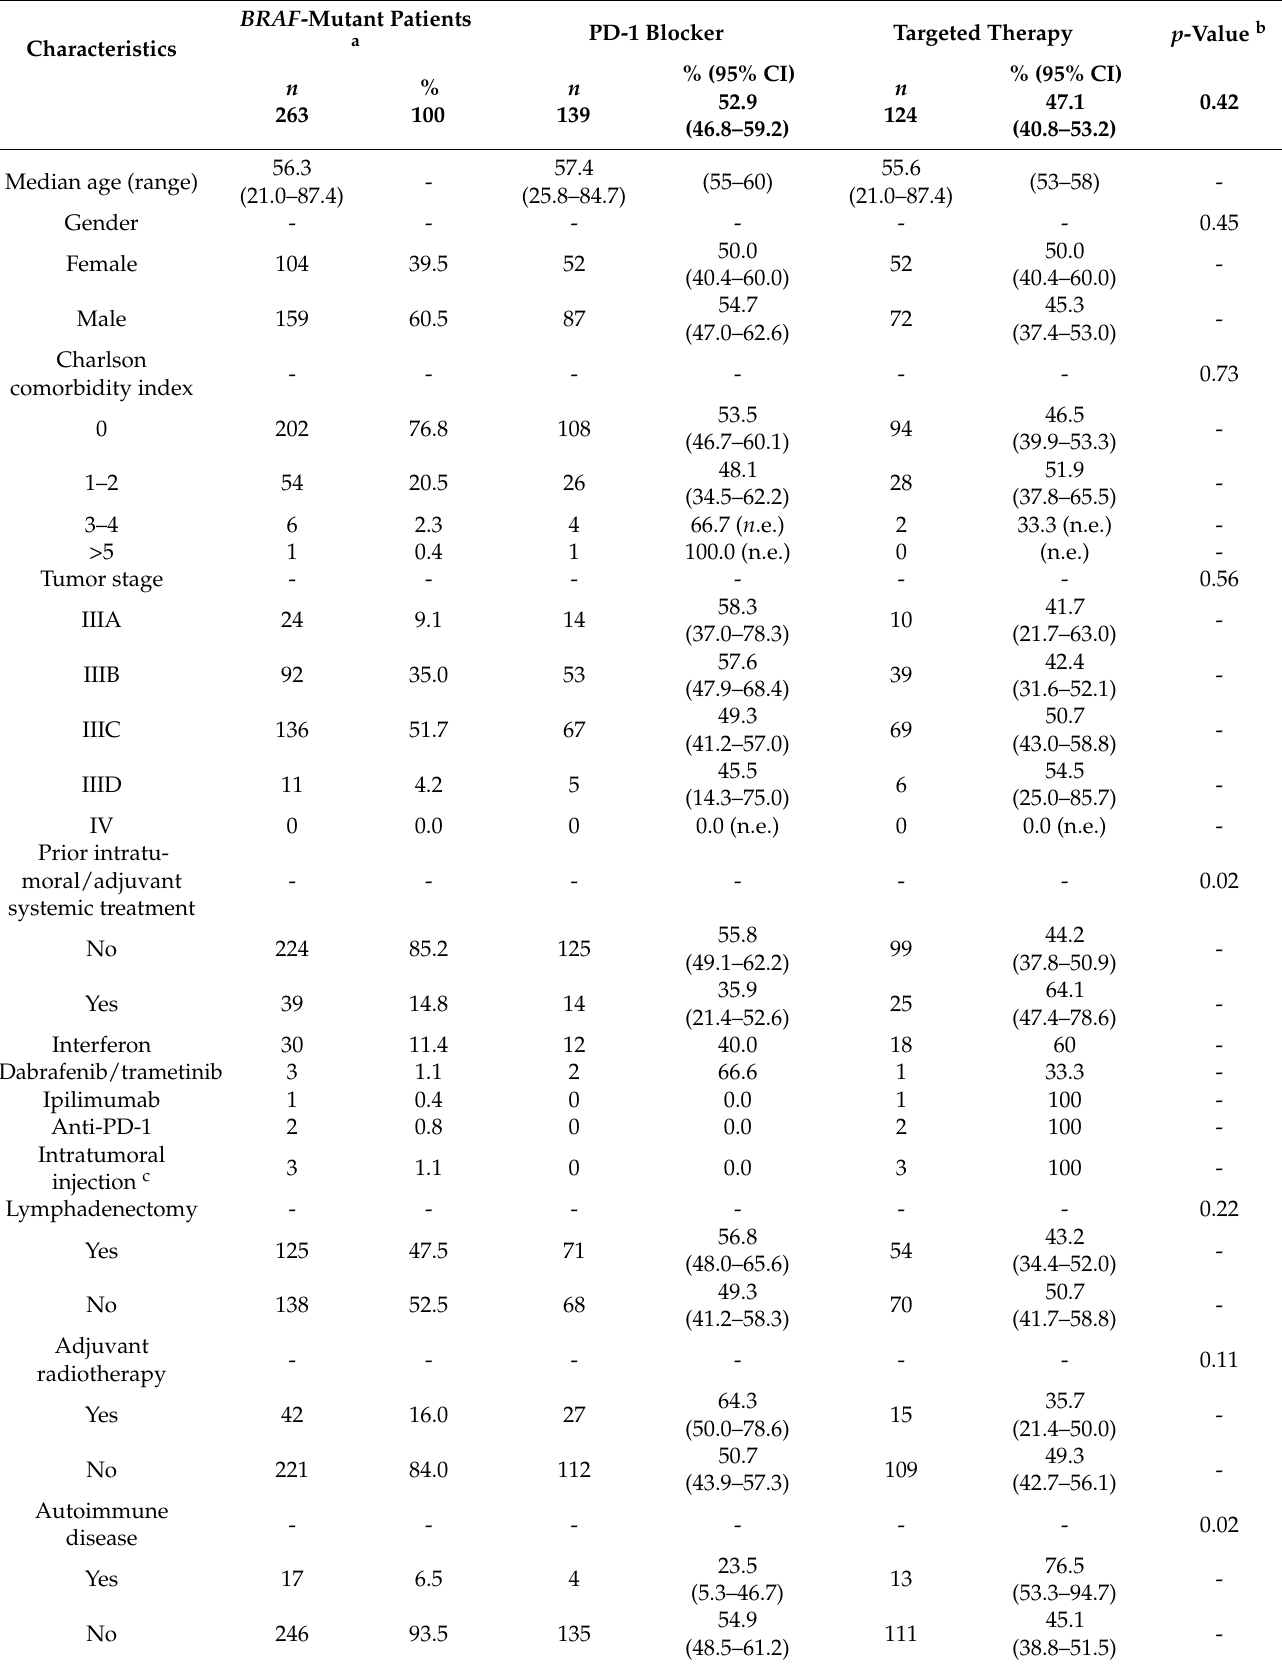
Table 4. Patient characteristics of the cohort of BRAF -mutant patients with adjuvant treatment.